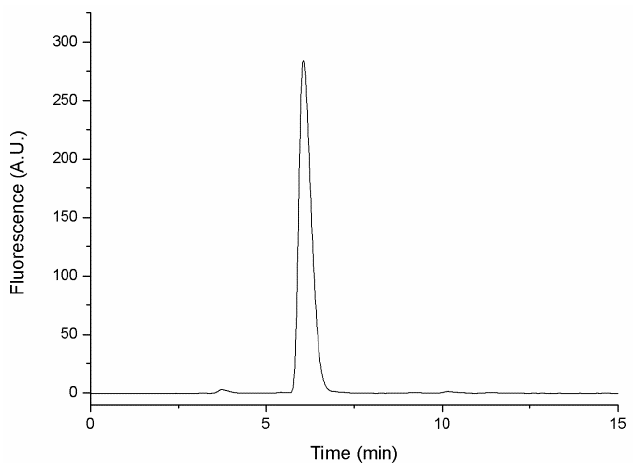
Figure 3. HPLC chromatogram of GSH-OPA derivative.